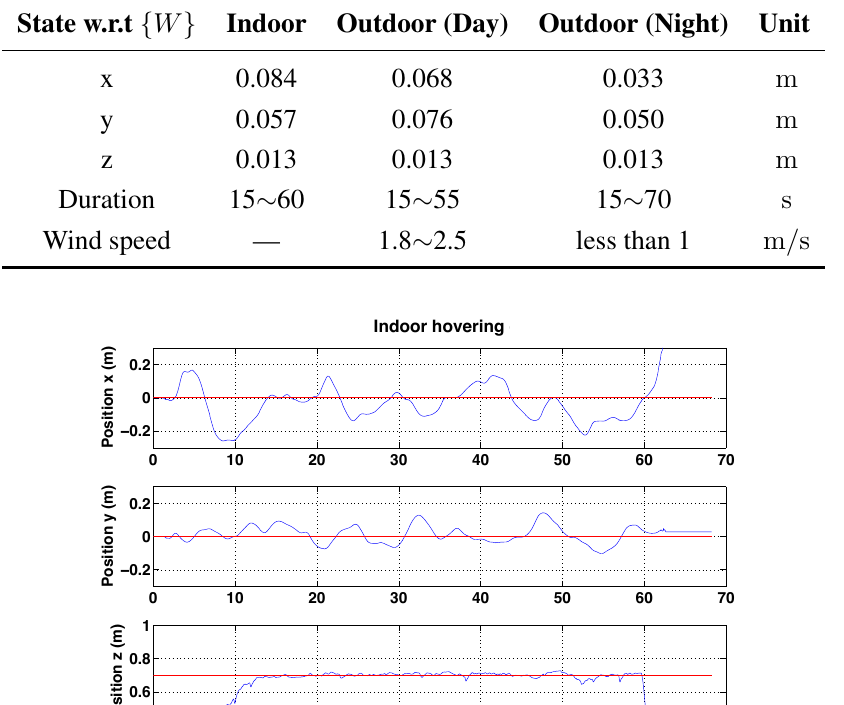
Table 2. Hovering standard deviation performance summary of Figures 30–32.